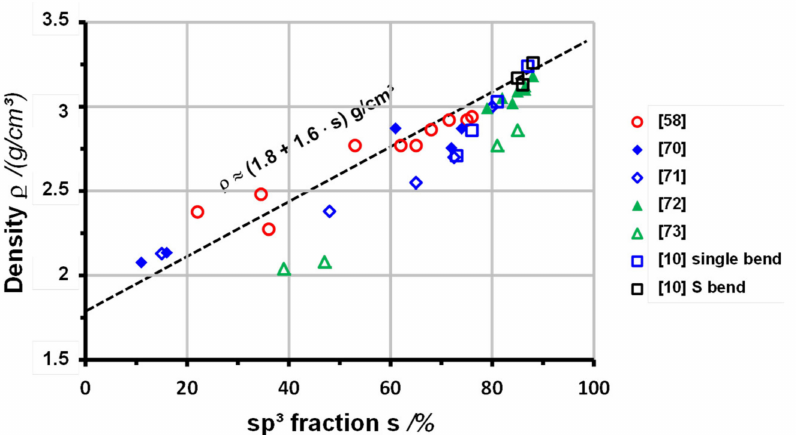
Figure 12. Relation of the density (derived from the plasmon energy according to Equation (5)) with the sp 3 fraction for carbon films, deposited by filtered dc arc at various ion energies. Data from Figures 10 and 11. Included pulsed arc (5 ms) with bias pulses of 2 µ s with duty cycle of 25% [10,58,70–73]. The black dashed line corresponds to Equation (1), approximately valid down to near s =